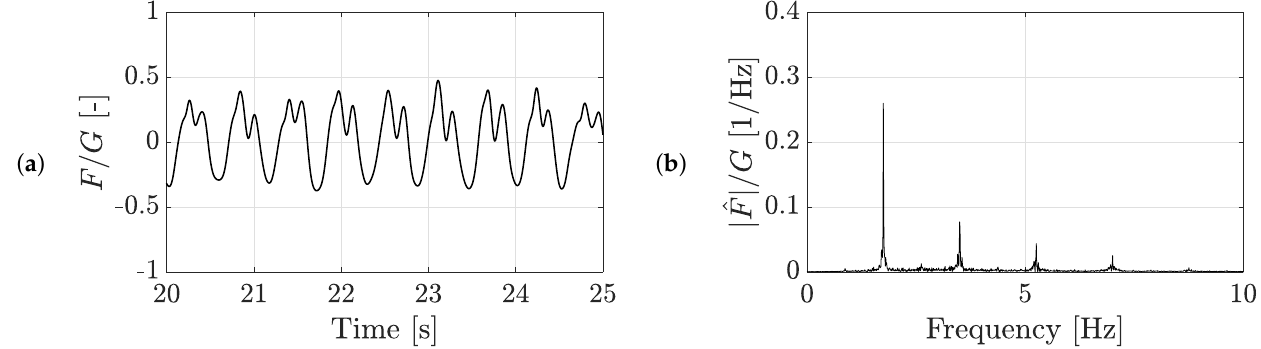
Figure 2. Vertical contact force with the static component removed from the reference trial (average walking speed of 4.5 km/h, average step frequency of 1.75 Hz) ( a ) time series and ( b ) amplitude spectrum normalized to the body weight.